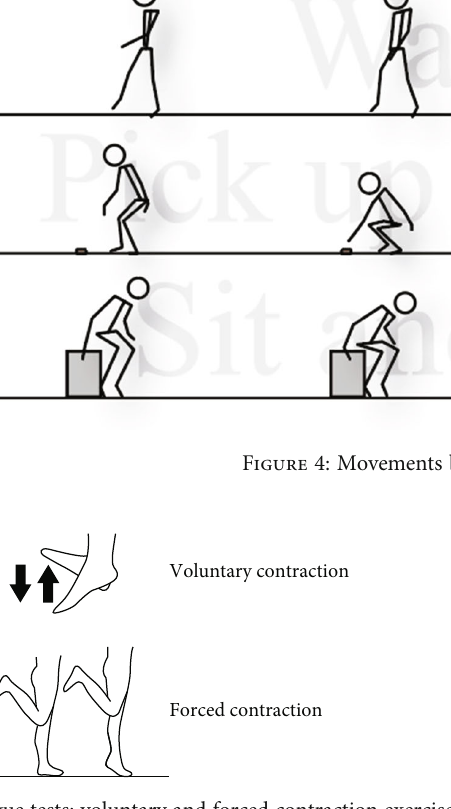
Figure 5: Fatigue tests; voluntary and forced contraction